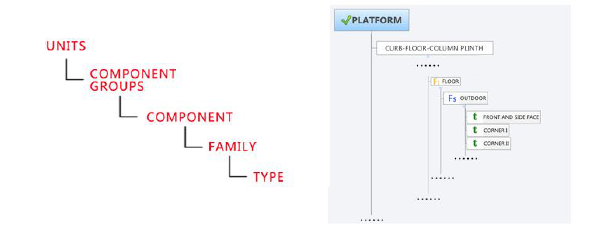
Figure 3. The hierarchic